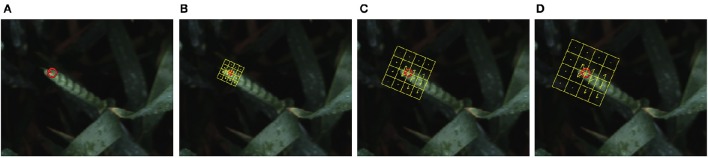
(A) A single keypoint candidate in the image; (B–D) SIFT descriptor calculated at different scales of 4, 8, and 10; At each scale, the descriptor has 4 × 4 patches (color coded in yellow), which are rotated to the dominant orientation of the feature point. Each patch is represented in gradient magnitudes of eight directions, represented by yellow arrows inside each bin.